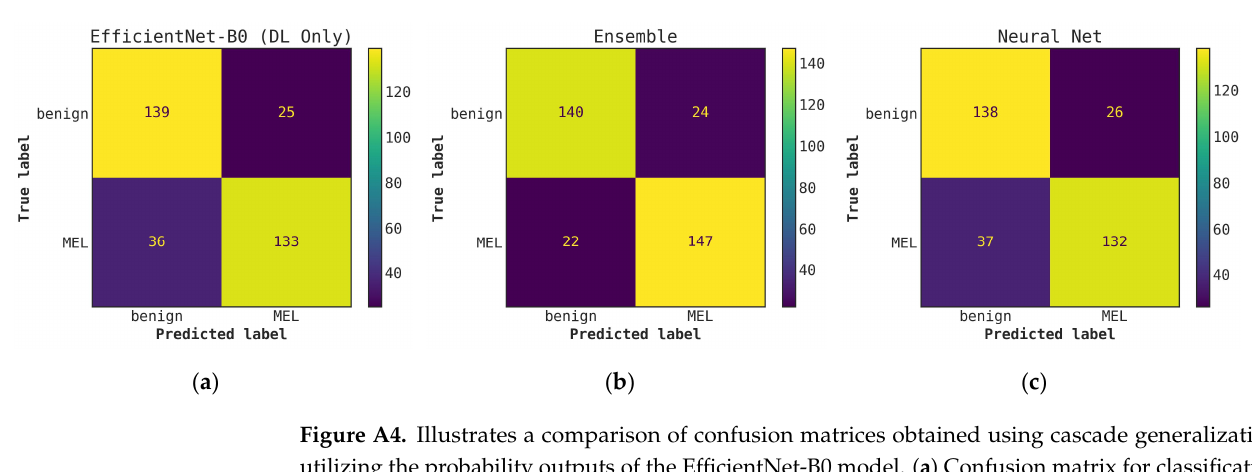
Figure A3. Comparison of confusion matrices for DL classifiers without cascade generalization on the classification hold-out test set. ( a ) ResNet50; ( b ) EfficientNet-B0; ( c ) EfficientNet-B1; ( d ) Ensemble of DL classifier models.